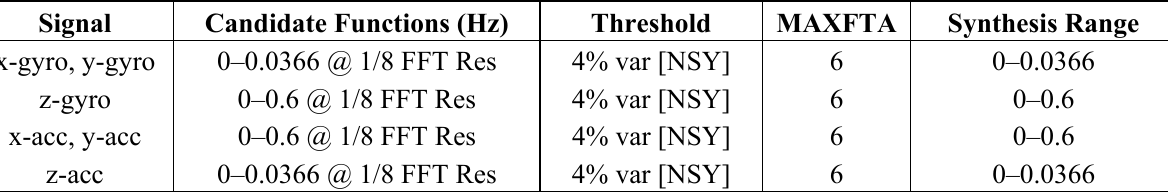
Table 2. FOS de-noising